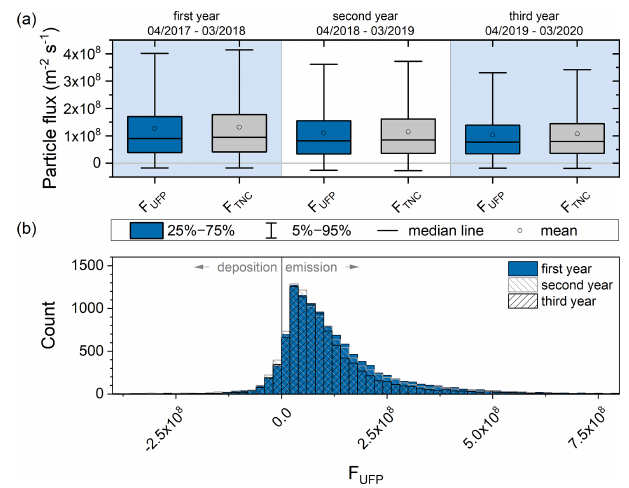
Figure 6. (a) Range of F TNC and F UFP and (b) the frequency dis- tributions of F UFP for each of the 3 years of measurement. Please note that the date format used in this figure is month/year.